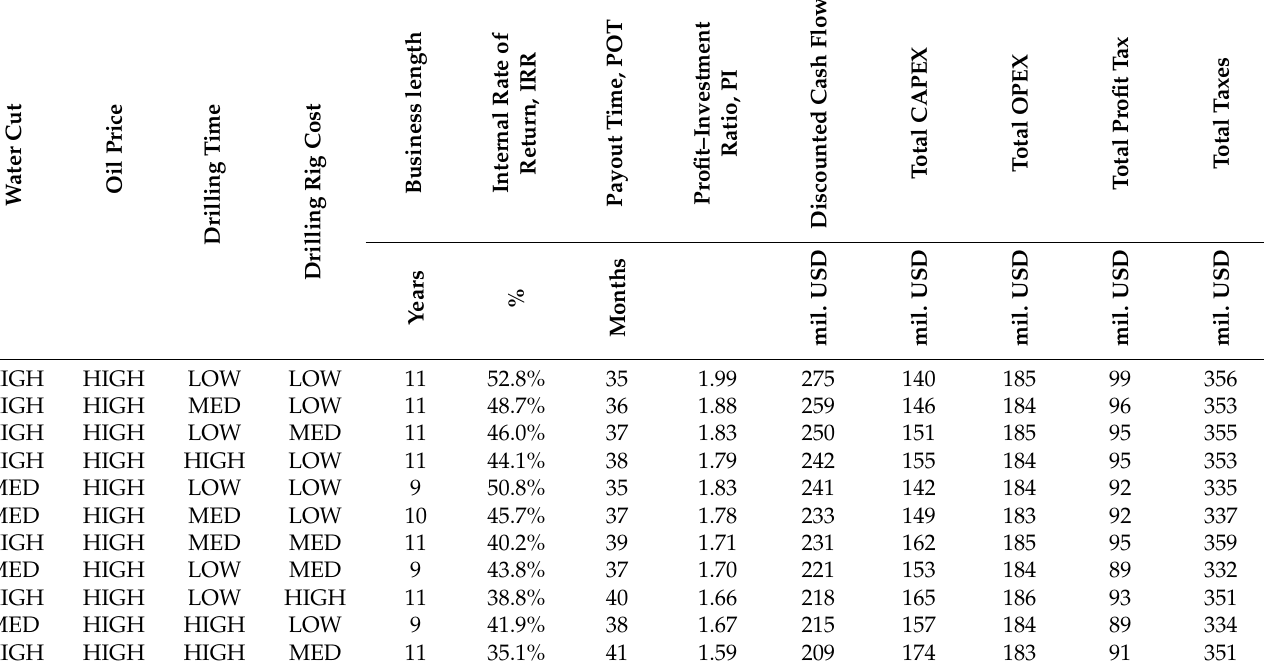
Table 8. The Profitable Sub-Cases—Alternate Field